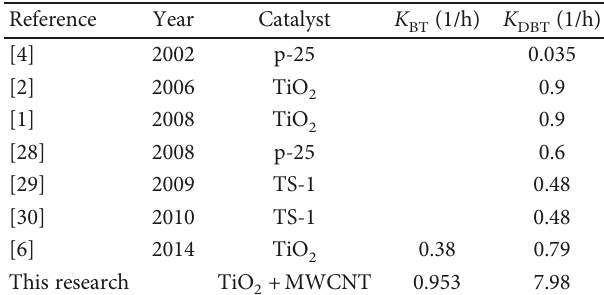
Table 6: Reaction rate constant in di ff erent